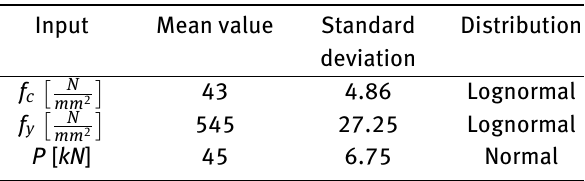
Table 1: The mean value, standard deviation and distribution for the input variables